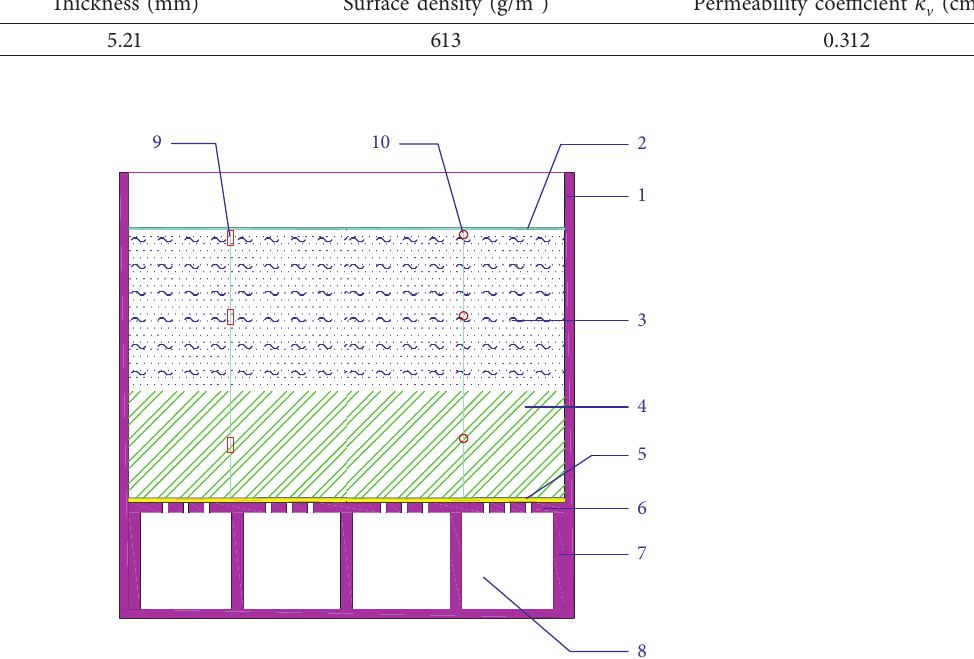
Figure 5: The test model and the monitoring points. 1, model box; 2, sealing membrane; 3, sludge; 4, straw; 5, permeable geotextile; 6, diaphragm plate; 7, support; 8, hollow space; 9, pore pressure gauges; and 10, vacuum monitoring points.